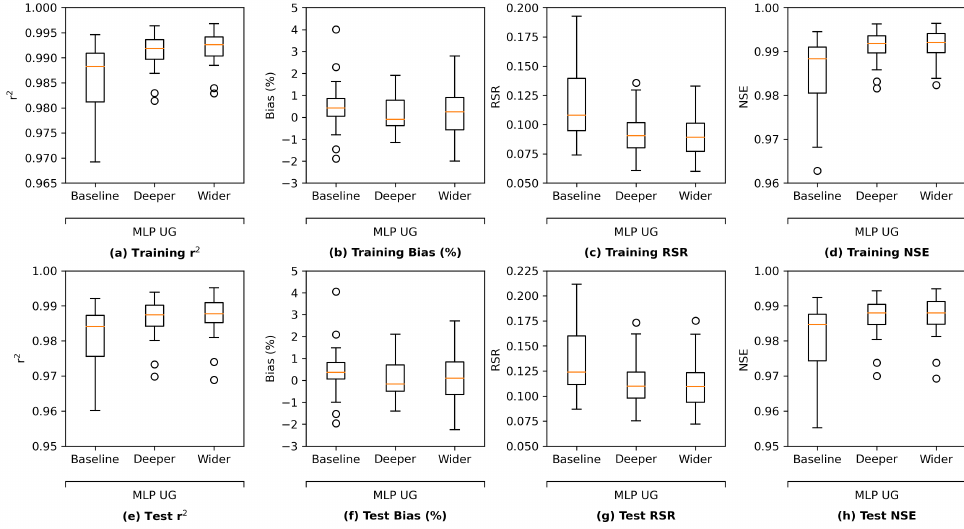
Figure 14. Performance comparison of the baseline MLP (ungrouped) versus its deeper and wider versions illustrated in Figure